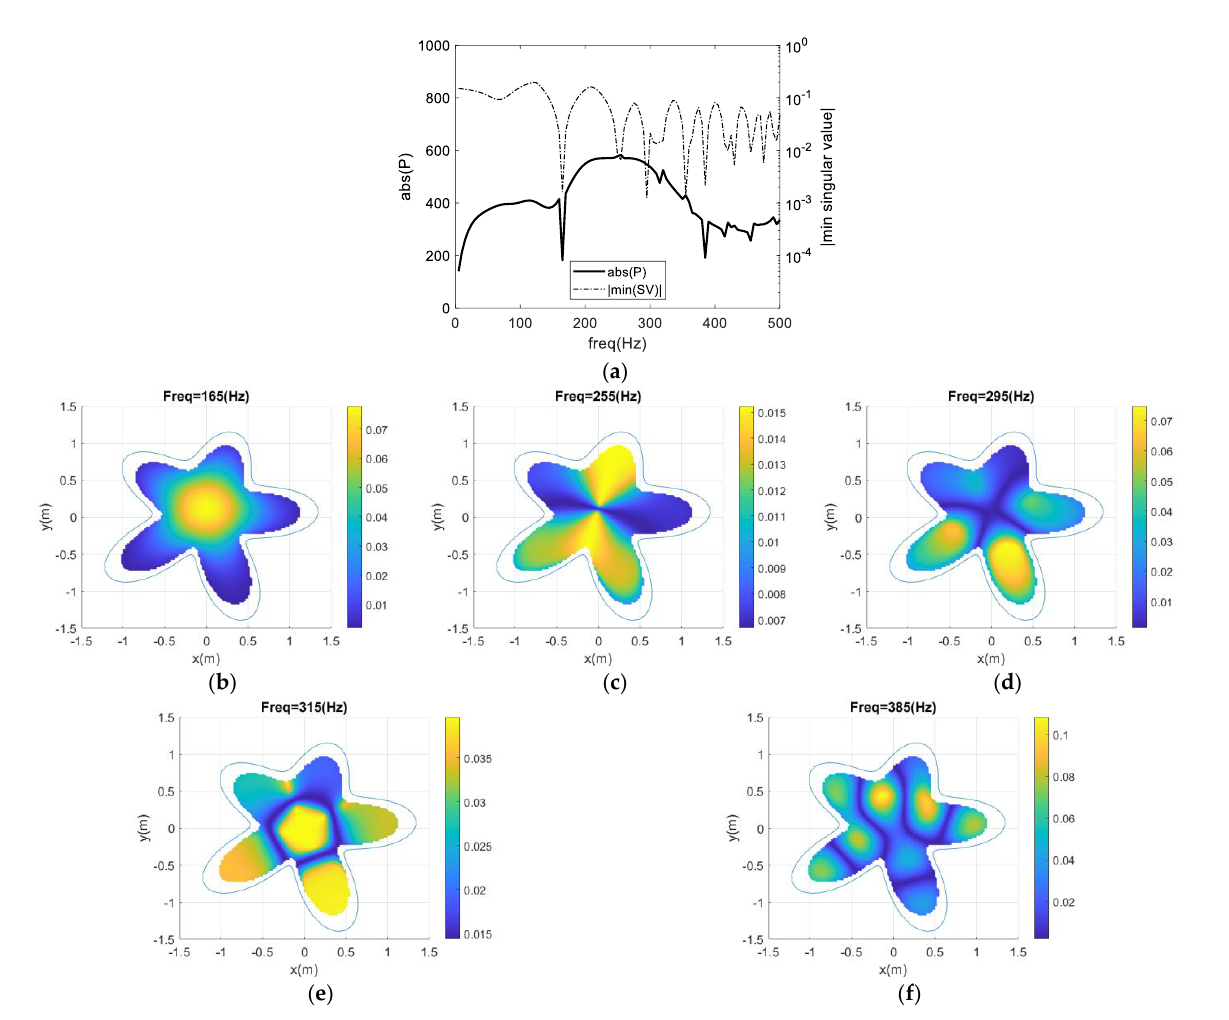
Figure 12. ( a ) BEM response for the second test case, and ( b – f ) color maps of the minimum singular value of the system matrix when one CHIEF point is considered for different frequencies.